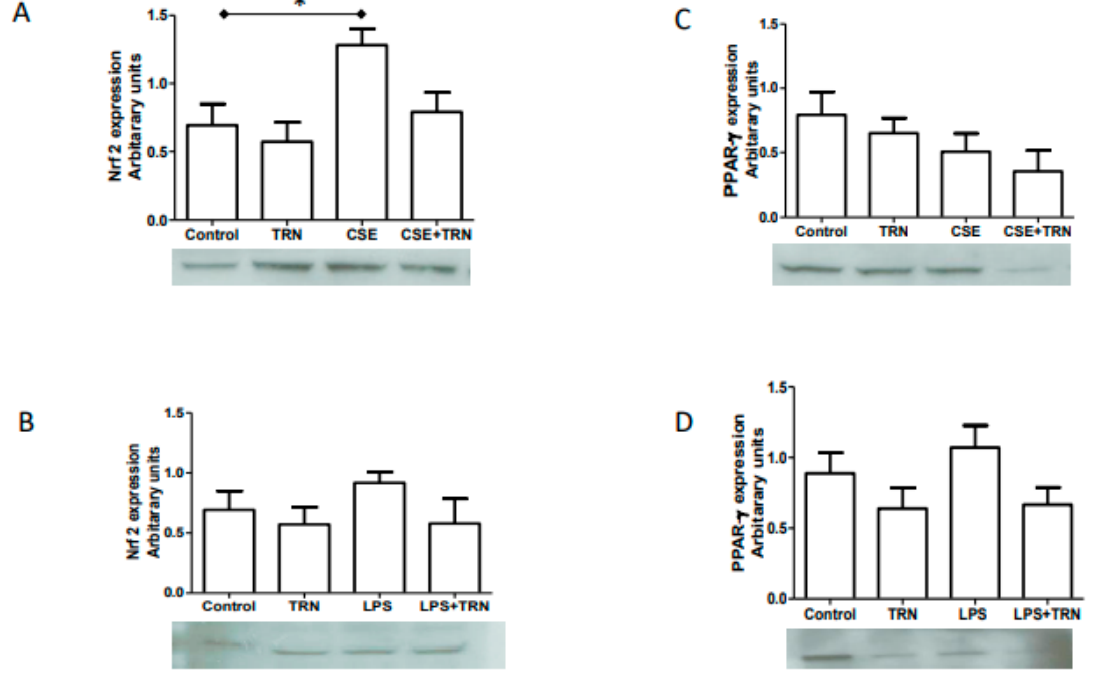
Figure 2. Representative western blots of Nrf2 (100 kDa) and PPAR γ (53 kDa) expressions in fetal membranes and its graphical representation of data ( n = 6) after 6 h of treatment with various factors; * p < 0.05. ( A ): Fetal membranes treated with trigonelline (TRN), cigarette smoke extract (CSE) and CSE + TRN. ( B ): Fetal membranes treated with trigonelline (TRN), lipopolysaccharide (LPS) and LPS + TRN. ( C ): Fetal membranes treated with TRN, CSE and CSE + TRN. ( D ): Fetal membranes treated with TRN, LPS and LPS + TRN.